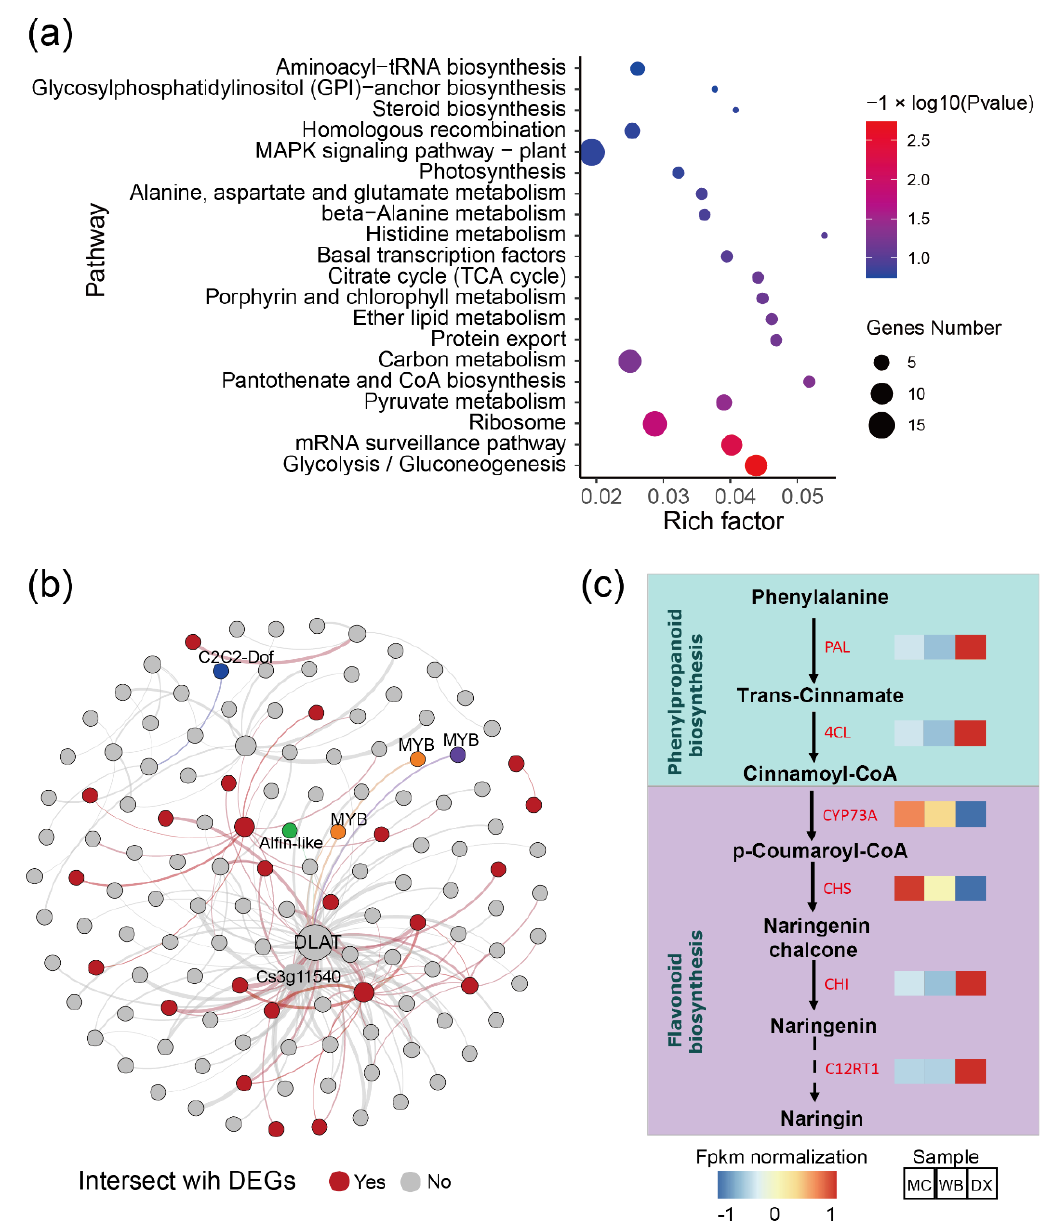
Figure 4. Co-occurrence network analysis based on the genes in module brown. ( a ) Pathway enrichment of genes in the brown module ( p value ≤ 0.05 are shown). Node size represents the number of differential genes within the pathway and color represents the significance of the pathway. ‘Gene number’ is the number of genes enriched in a pathway. ‘Rich factor’ is the percentage of total DEGs in the given pathway term. ( b ) Co-occurrence network analysis based on hub genes with the principles of adjacency threshold > 0.4. Nodes that are red represent genes intersecting with DEGs between MC and WB vs. DX. Genes annotated to TFs are marked. Node size represents the degrees of the genes in the network. ( c ) Gene expression in the biosynthesis of naringin. FPKM was normalized and is shown in color. PAL , phenylalanine ammonia-lyase. 4CL , 4-coumarate-CoA ligase. CYP73A , trans-cinnamate 4-monooxygenase. CHS , chalcone synthase. CHI, chalcone isomerase. C12RT1 , flavanone 7-O-glucoside 2 (cid:48)(cid:48) -O-beta-L-rhamnosyltransferase. The blue module (containing 3156 genes) was positively associated with 2,4,2 (cid:48) ,4 (cid:48) - tetrahydroxy-3 (cid:48) -prenylchalcone (R = 0.88, p = 0.002), astilbin (R = 0.77, p = 0.02), naringenin- 7-O-neohesperidoside (naringin) (R = 0.84, p = 0.004) and